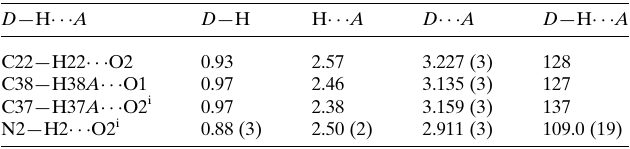
Table 1 Hydrogen-bond geometry (A˚ , (cid:2)